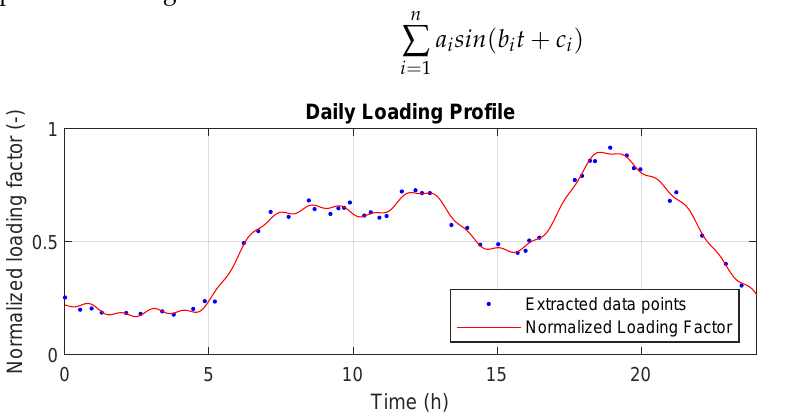
Figure 4. Daily loading profile of LV distribution network [13].